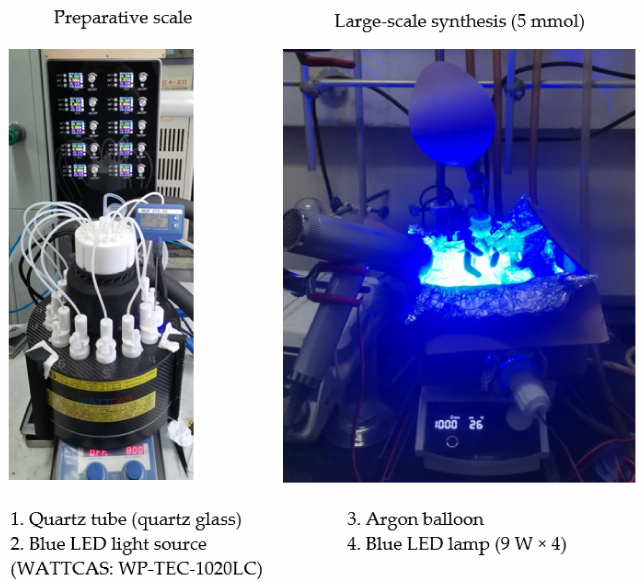
Figure 3. Reaction